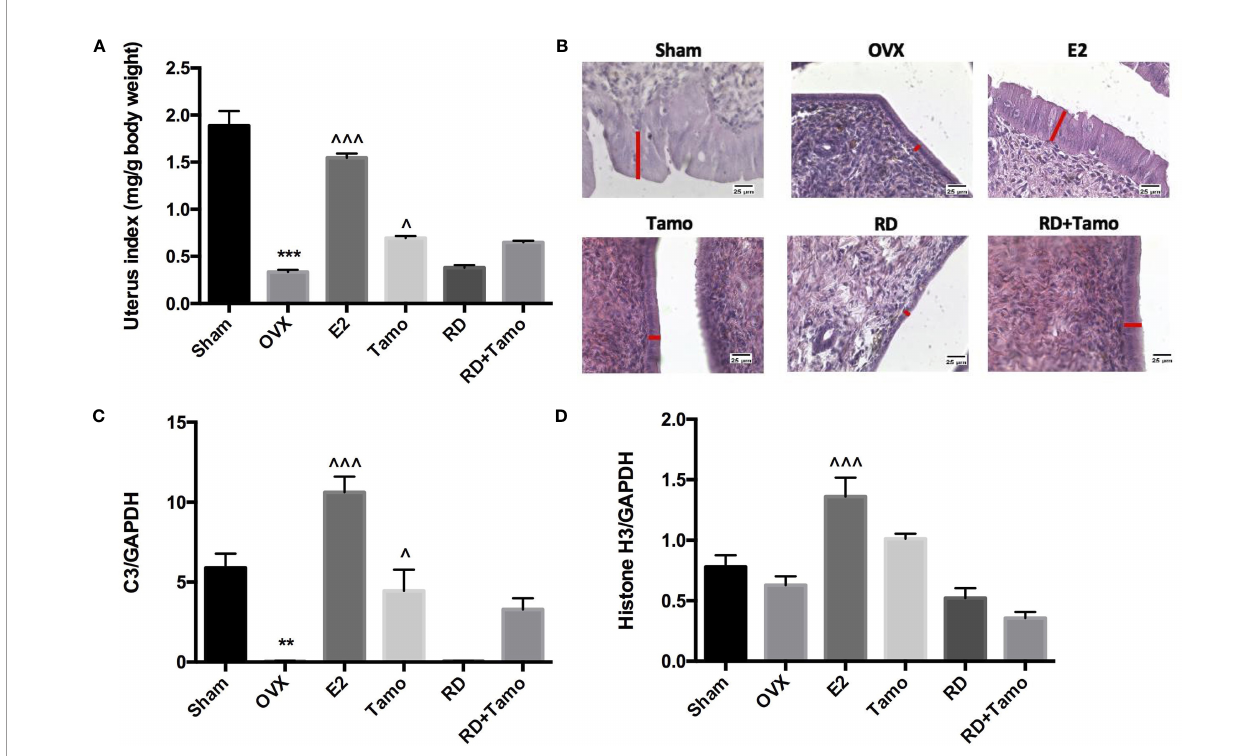
FIGURE 4 | Estrogenic effects of RD, tamoxifen, and their combinations on uterine index, mRNA expression of estrogen-responsive gene, and endometrial morphology in mature ovariectomized rats. Upon treatment, uterus was collected and weighed at euthanasia. Ratio of the uterus weight to body weight was recorded as uterine index (mg/g) and compared between groups (A) . Morphology of endometrium (×400, thickness of endometrium was indicated by the length of the red line) was visualized by H&E staining (B) . mRNA expression of complement component 3 ( C3 ) and histone H3 were measured by real-time PCR (C, D) . Data were expressed as mean ± SEM. n = 6 to 10. ** p < 0.01, *** p < 0.001 vs. Sham; ^ p < 0.05, ^^^ p < 0.001 vs. OVX. p -value of two-way ANOVA: 0.0847 for uterine index, 0.4800 for C3/GAPDH, and 0.0003 for histone